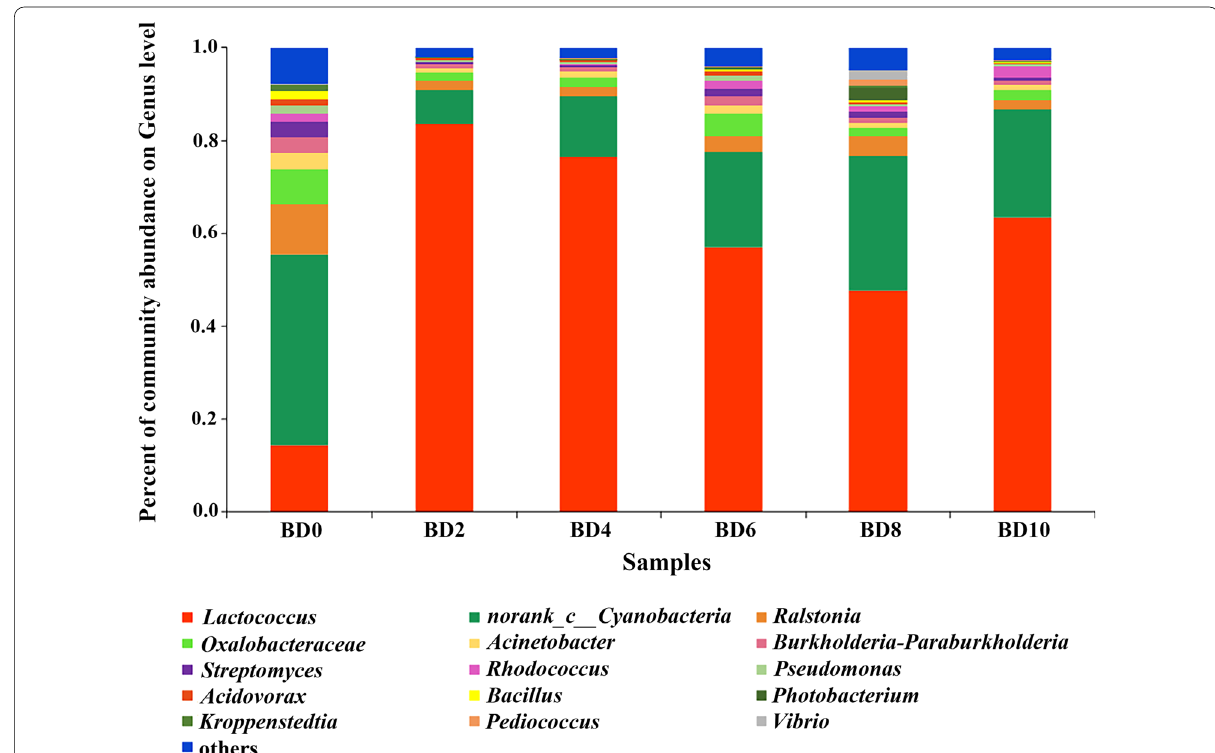
Fig. 3 Bacterial diversity during the fermentation process in northern Huangjiu at genus level. BD means “Beizong Huangjiu fermentation